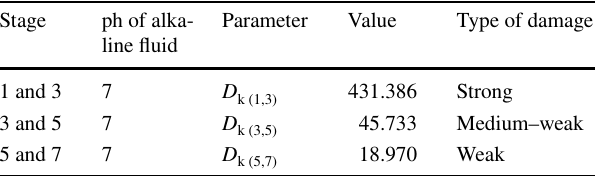
Table 5 Determination of the degree of formation damage ( D core no.